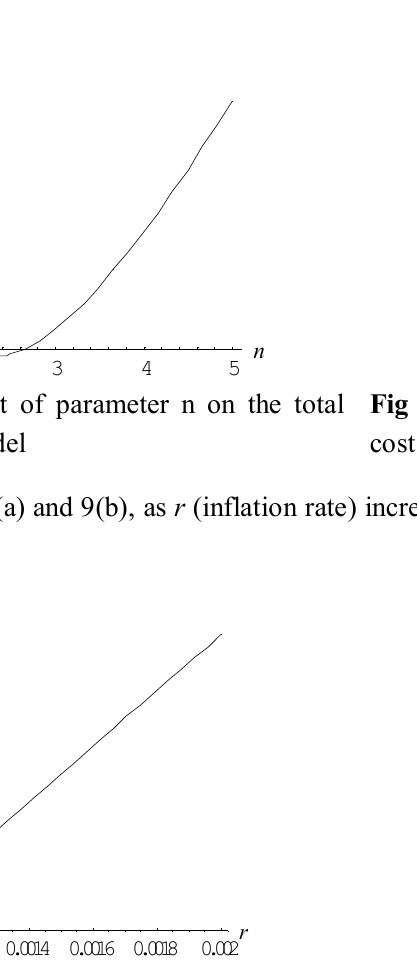
Fig. 9. (a) The effect of parameter r on the total cost in the crisp model